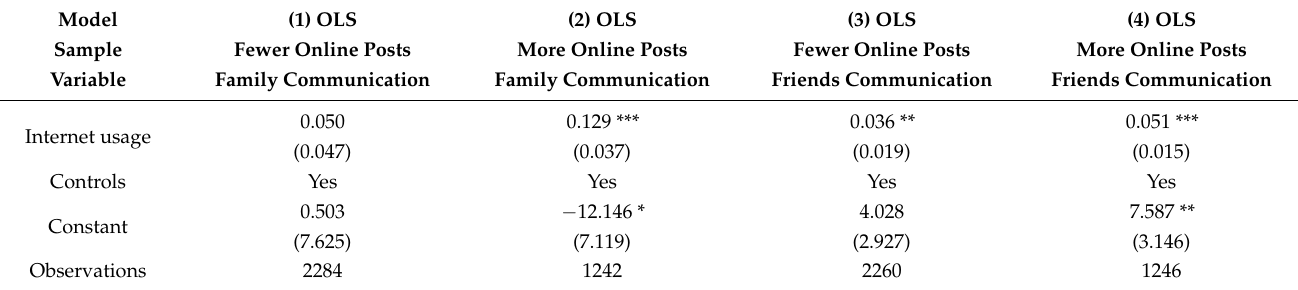
Table 10. Heterogeneity analysis in terms of online